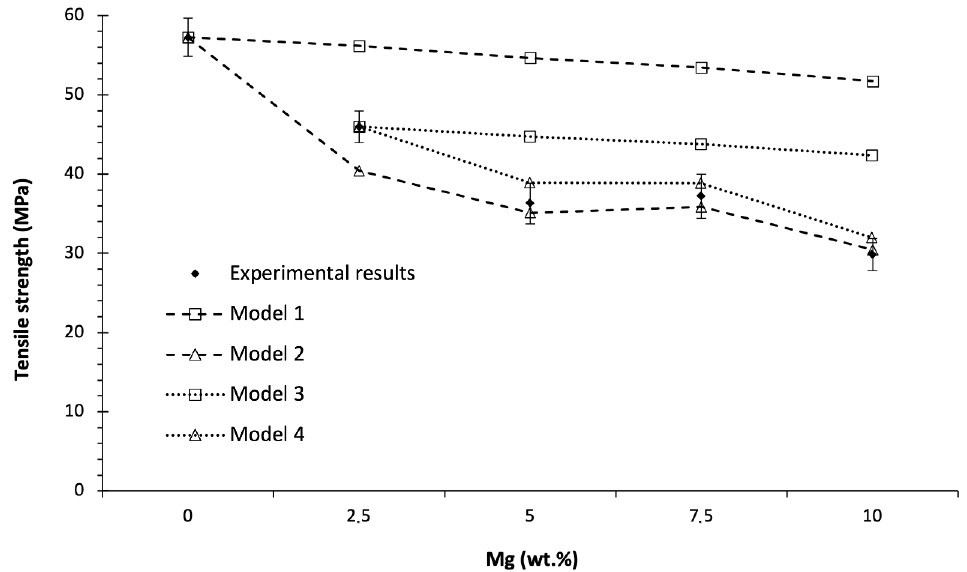
Figure 15. Evolution of the tensile strength of the PLA-Mg composites with the content of Mg particles. Theoretical values of the tensile strength are provided regarding different models. Experimental results are shown in bold.